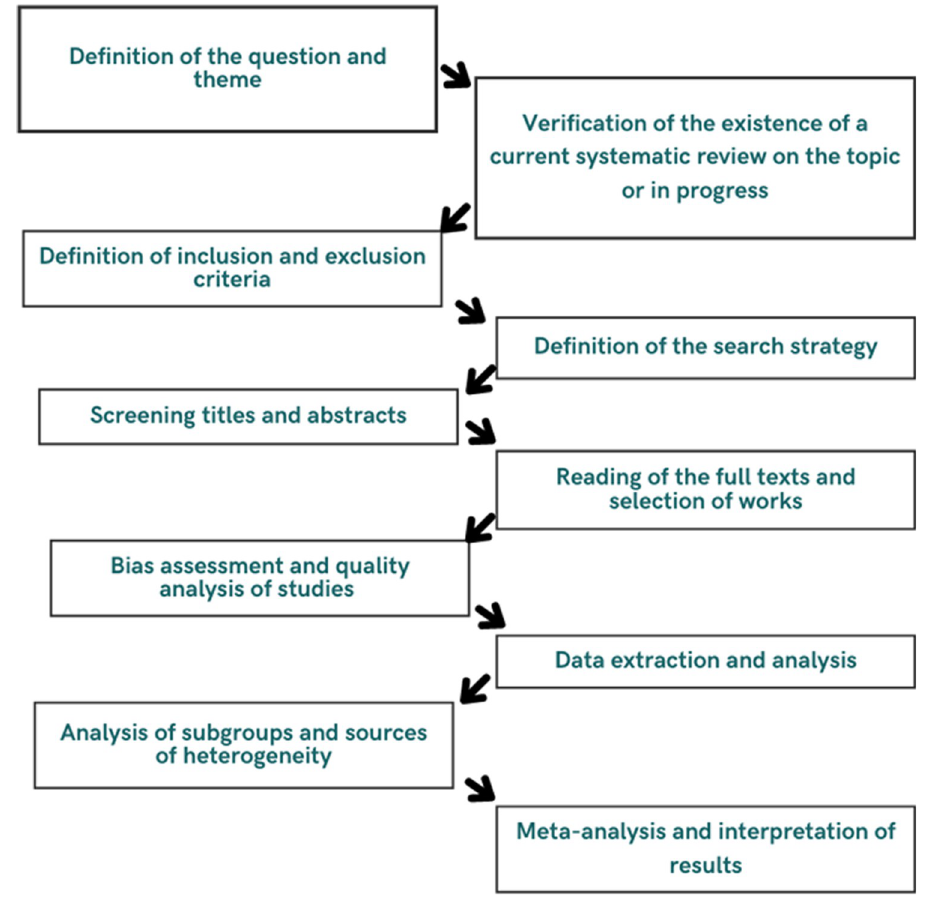
Fig 1. Flowchart steps of the systematic review.